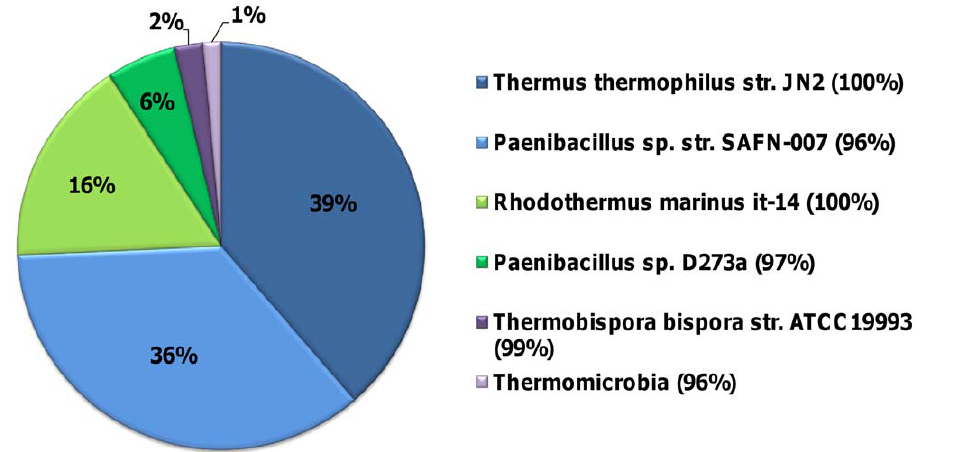
Figure 2. A pie chart showing the percent relative abundance of each taxon in the McCel-adapted thermophilic bacterial consortia. SSU pyrosequencing was conducted to identify community members. Only members with a relative abundance greater than 1% are reported. Relative abundance is calculated as a percentage of the total number of SSU reads for the community. The closest taxon to each organism in the community is reported in the legend. The percent identity between the consortial and closest taxon SSU sequence is in parentheses.